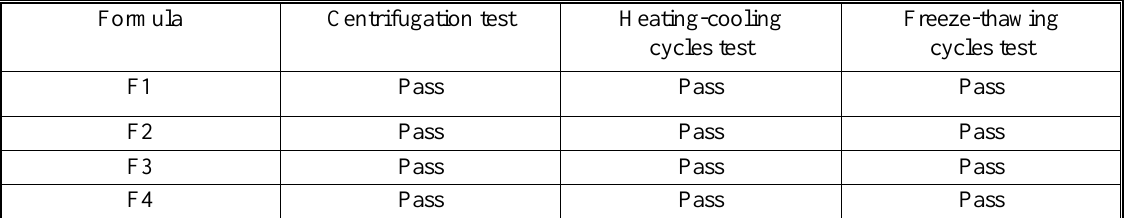
Table 3. Thermodynamic stability studies of tacrolimus liquid self-micro emulsifying drug delivery